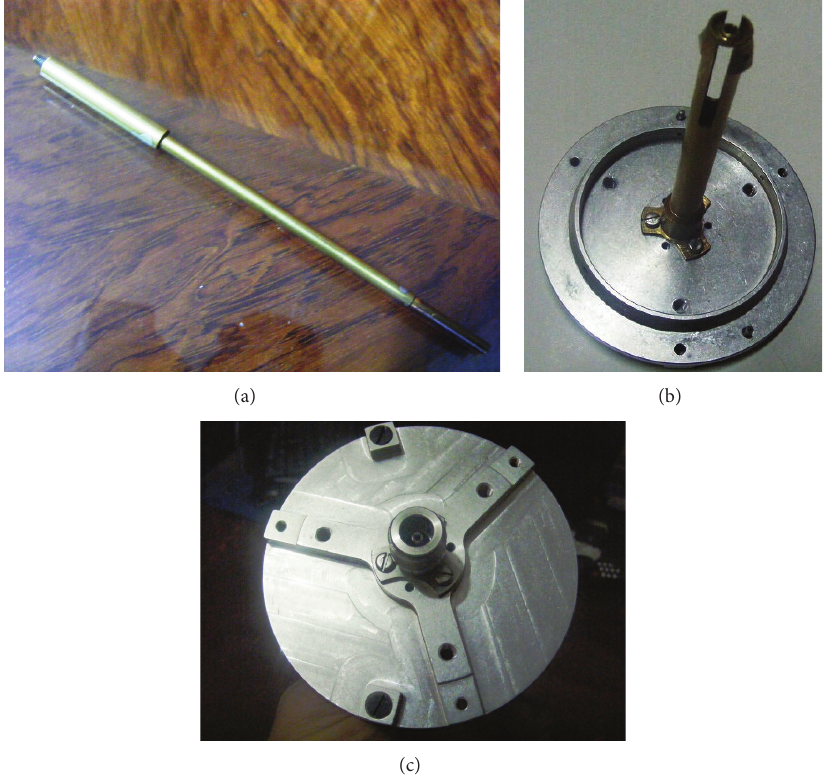
Figure 20: The manufactured balun: (a) the inner conductor with a step transition in its diameter, (b) the doubly-slotted outer conductor mounted on a metal disc, (c) the bottom side of the metal disc with N-type coaxial connector.